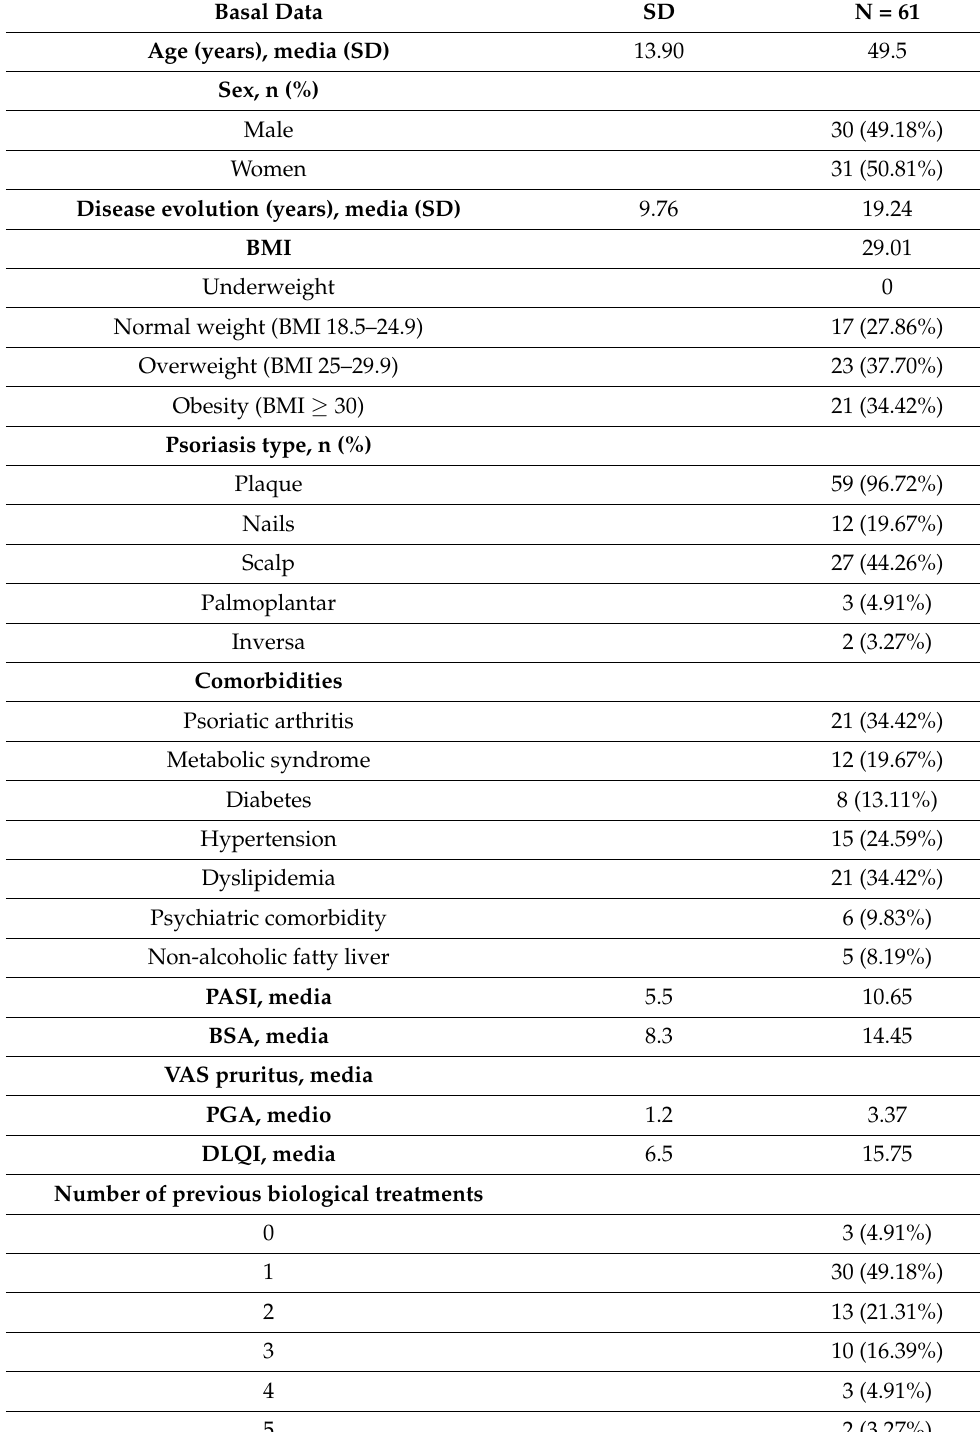
Table 1. Baseline characteristics of our